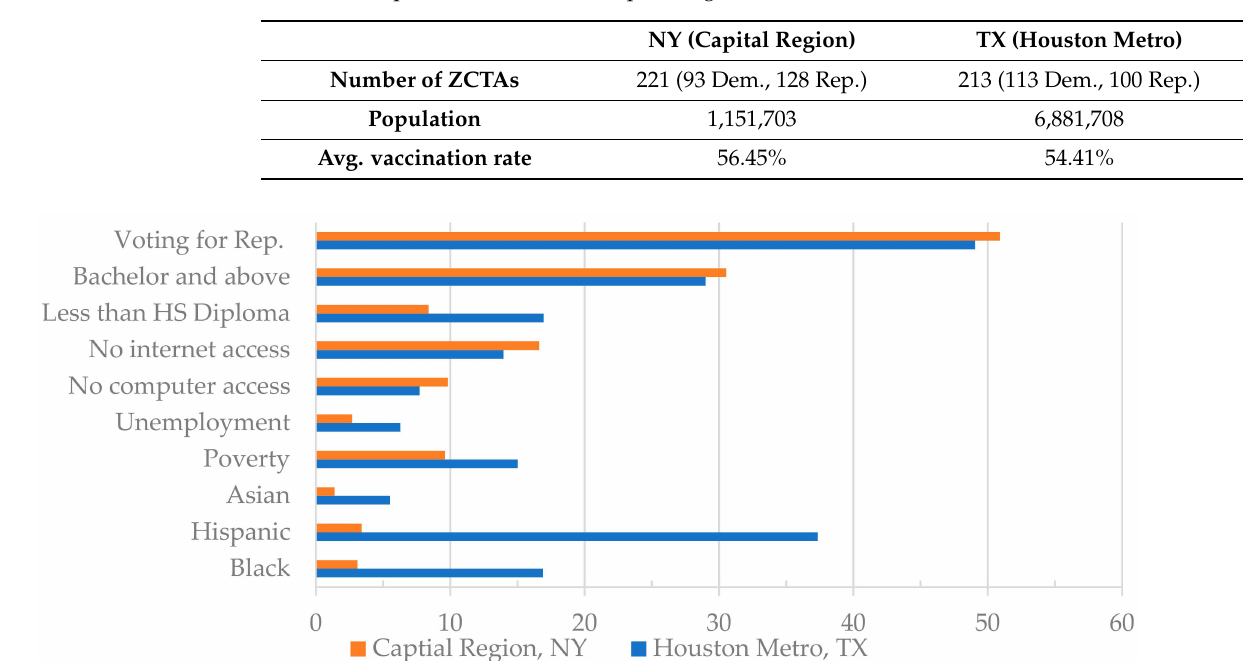
Figure 1. Percentage of population in the considered variables in each